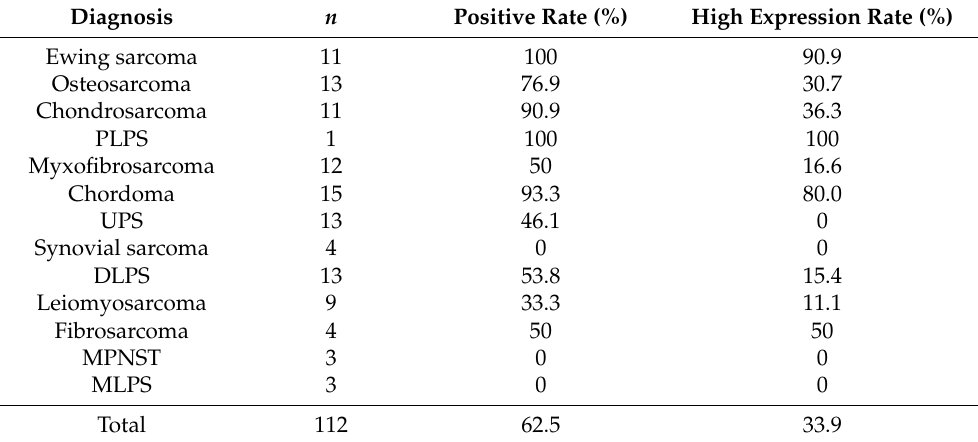
Table 2. GPR64 isoform 2 expression in sarcomas.